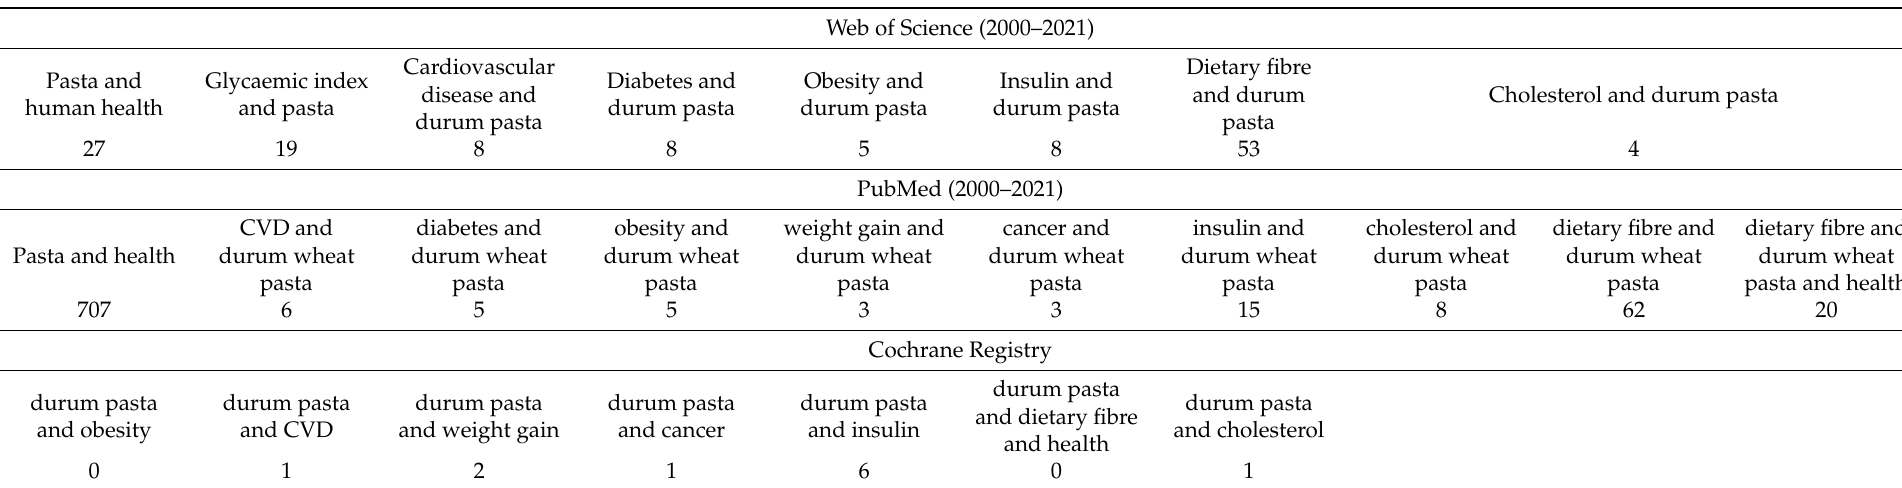
Table 3. Database search history showing database, search term and number of hits. Web of Science